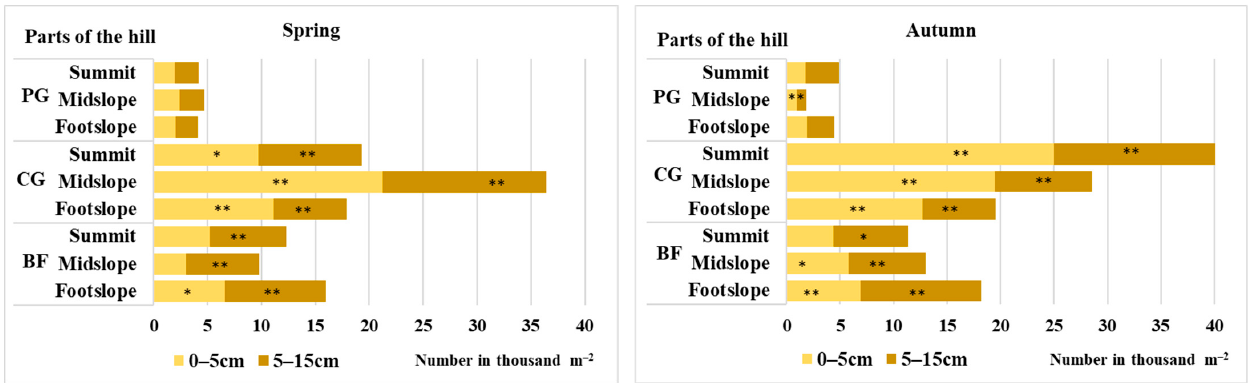
Figure 1. Soil seed bank in different agrophytocenoses, 2020–2021; PG—permanent grassland; CG— cereal–grass crop rotation; BF—crop rotation with black fallow. * and ** indicate significance at p ≤ 0.05 and p ≤ 0.01, respectively.